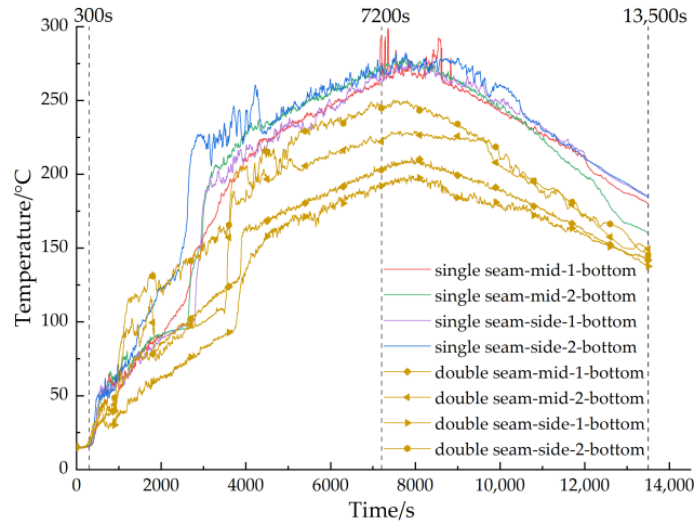
Figure 15. Time-temperature curves of measuring points on the surface of the bottom steel plate.